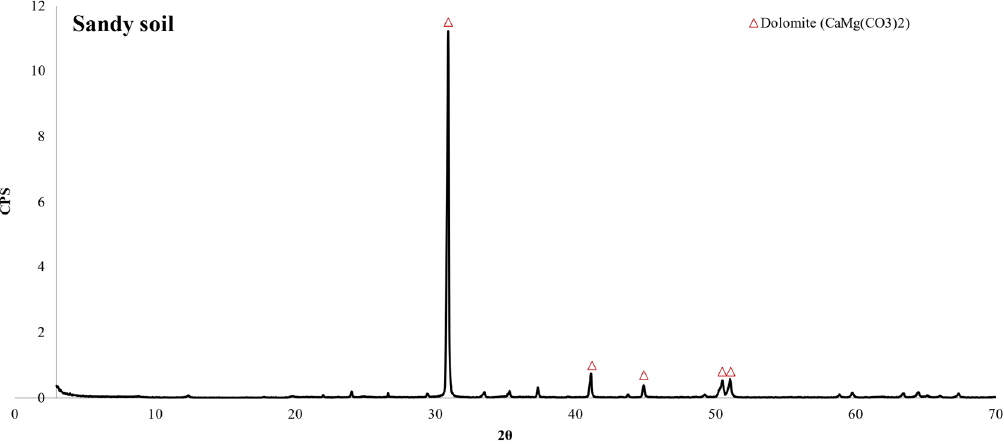
Figure 3. XRD of clayey soil.